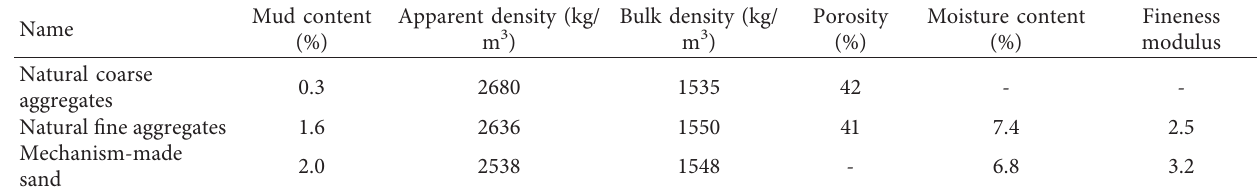
Table 4: Technical index of coarse and fine